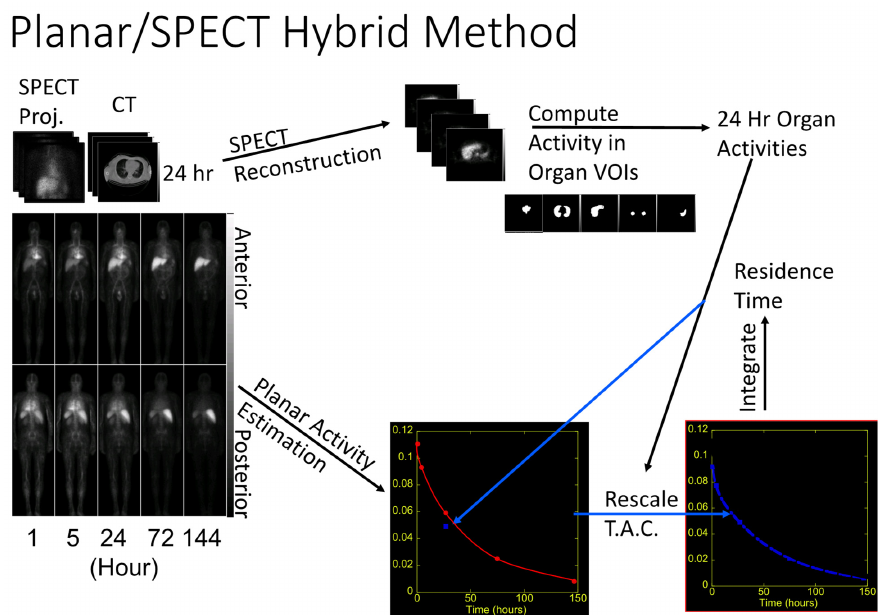
Figure 2. SPECT/CT + planar hybrid dosimetry method. The absolute radioactivity concentration in normal tissues is de- termined by SPECT/CT imaging performed 24 h after a tracer injection of 5 mCi of 111 In ibritumomab tiuxetan. The shape of the time-activity curve of radioactivity clearance is defined by sequential whole-body planar conjugate view images. MIRD formalisms are applied with regions-of-interest and organ volumes informed by the CT from the SPECT/CT. 2.3. Radiolabeling and Dose Infusion The 111 In ibritumomab tiuxetan and 90 Y ibritumomab tiuxetan were prepared from FDA-approved kits supplied by Biogen/IDEC. The kits were designed to provide a 185 MBq (5 mCi) 111 In dose for imaging or a maximum of 1.18 GBq (32 mCi)/kit of 90 Y. To administer therapeutic doses greater than 1.18 GBq, additional kits were required, each